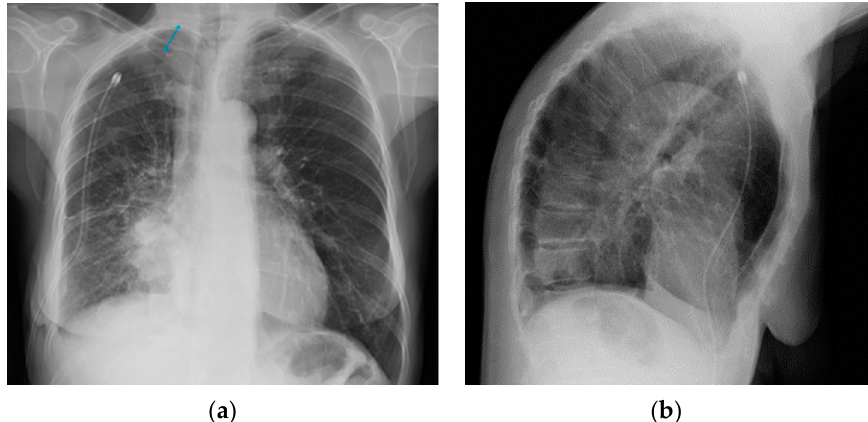
Figure 28. Right apical chest drainage tube in patient with right pneumothorax (blue arrow) on PA ( a ) and LL ( b ) projections.